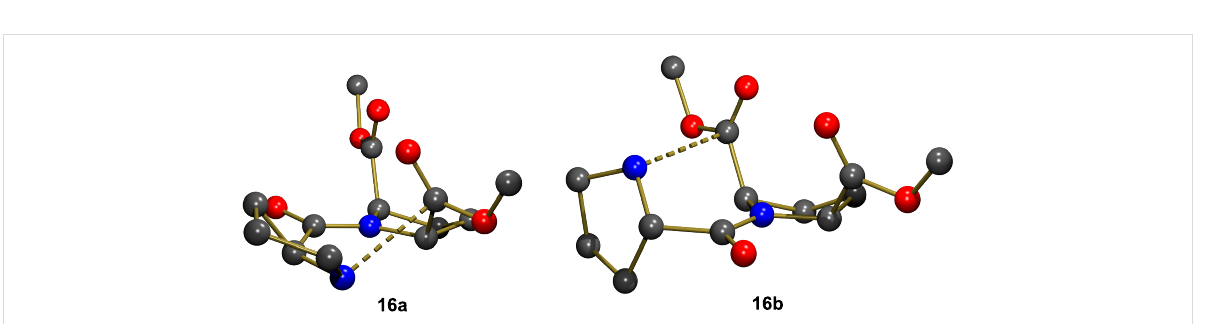
Figure 1: Optimized geometries for the two conformers presenting interactions with either C a ( 16a ) or C b ( 16b ). H atoms were omitted for clarity.